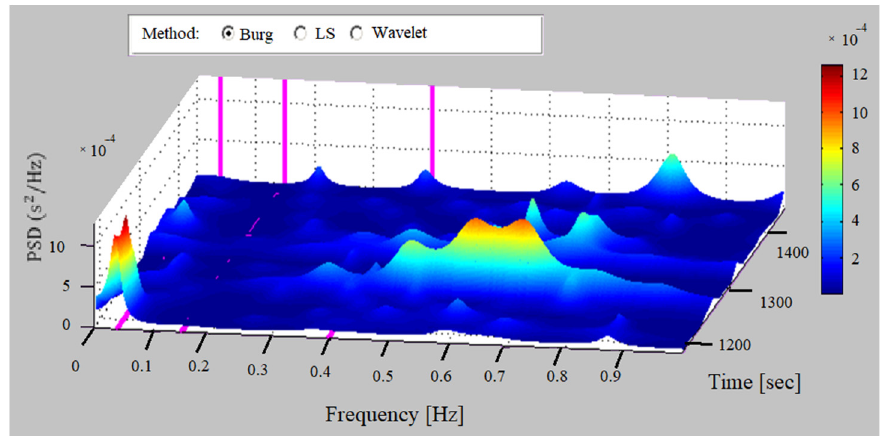
Figure 13. Surface method (heart failure).